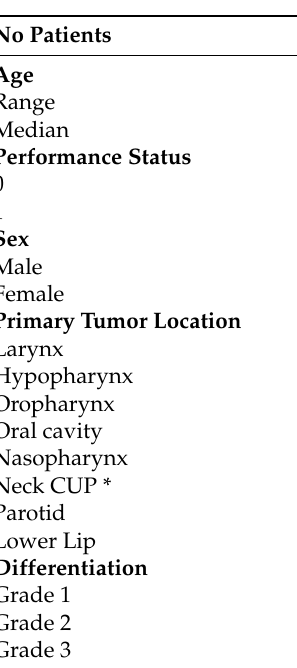
Table 1. Patient and disease